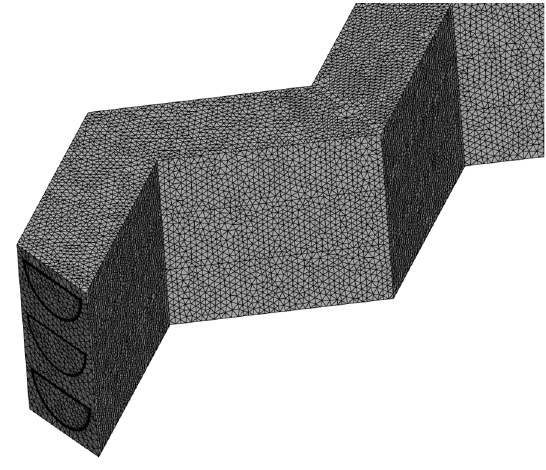
Figure 4. The grid of PCHE.